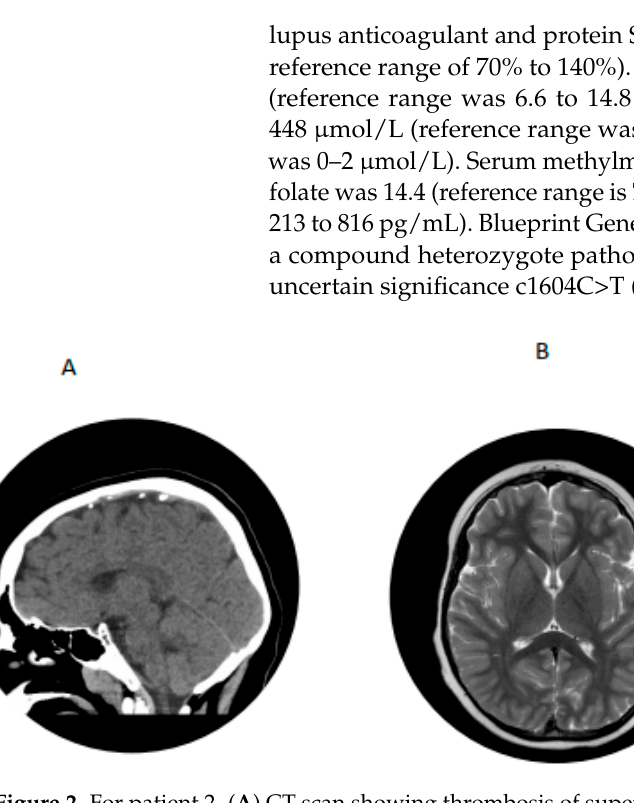
Figure 2. For patient 2. ( A ) CT scan showing thrombosis of superior sagittal sinus. ( B ) Brain MRI showed filling defect in superior sagittal sinus. ( C ) MRV showing dural venous thrombosis with extensive superficial and deep collateral